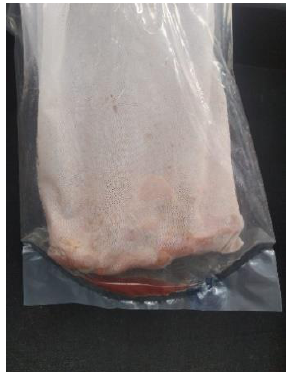
Figure 2. Resultant exudate at the bottom of the bag after homogenizing the sample with the paddle blender. Exudate was collected with a sterile syringe and placed in a sterile container for testing.